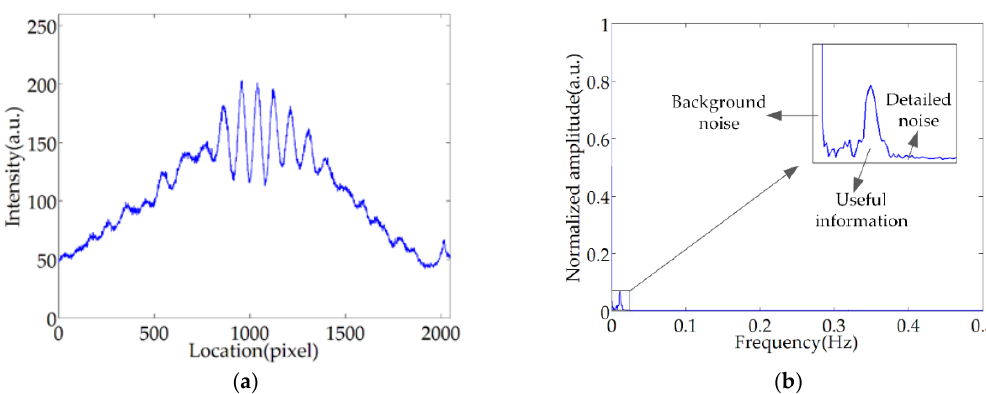
Figure 3. Low-coherence interference fringe: ( a ) spatial distribution of the fringe; ( b ) frequency domain information of the fringe.